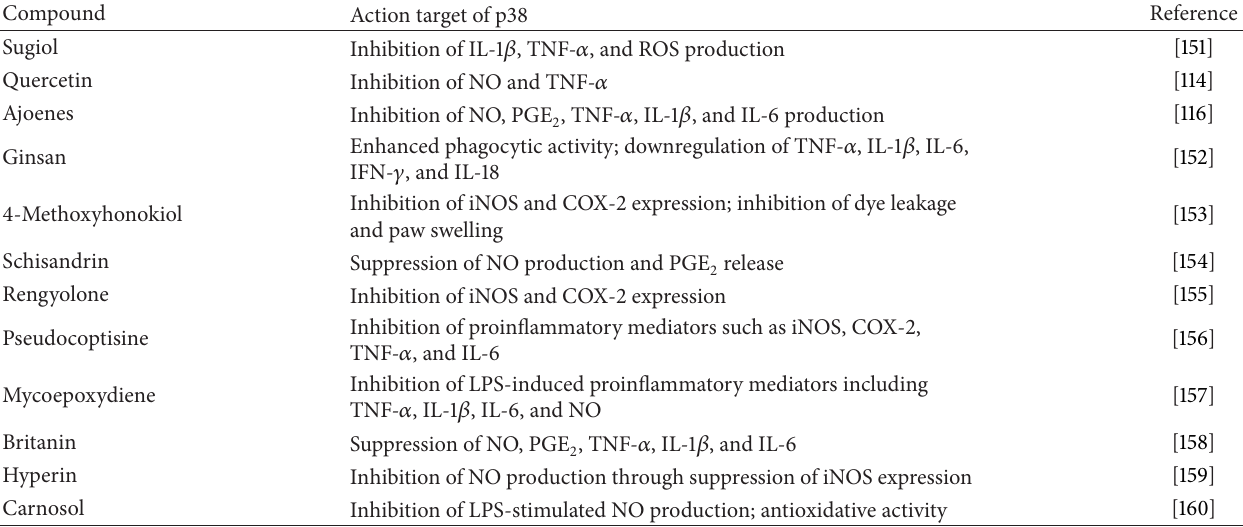
Table 3: Naturally occurring compounds that inhibit p38 signaling in macrophages.